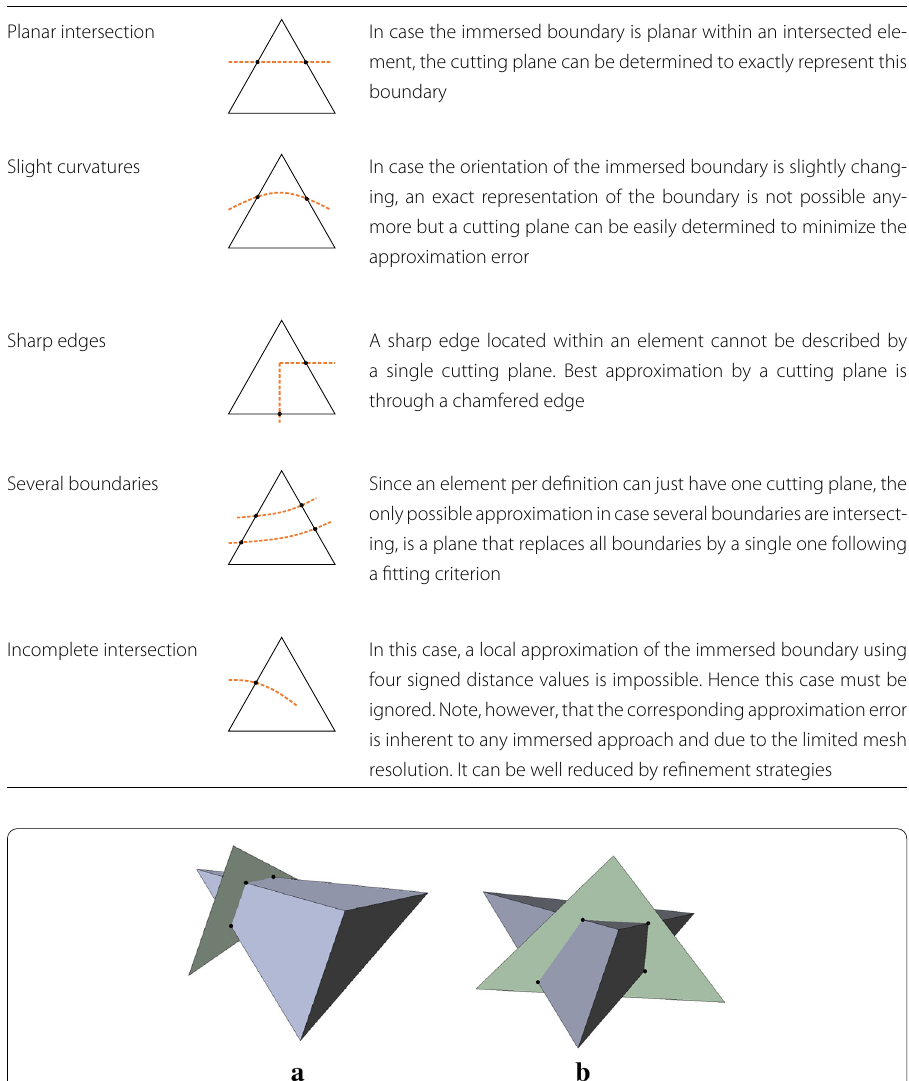
Table 1 Scenarios of immersed geometries leading to different intersection patterns—the geometric complexity increases from the top to the bottom of the table Scenario